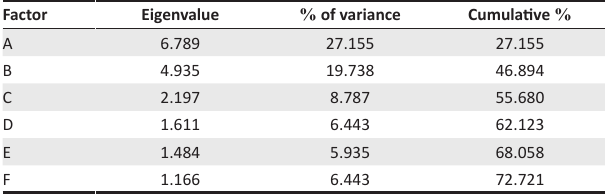
TABLE 3: Factors with eigenvalues greater than 1.00.